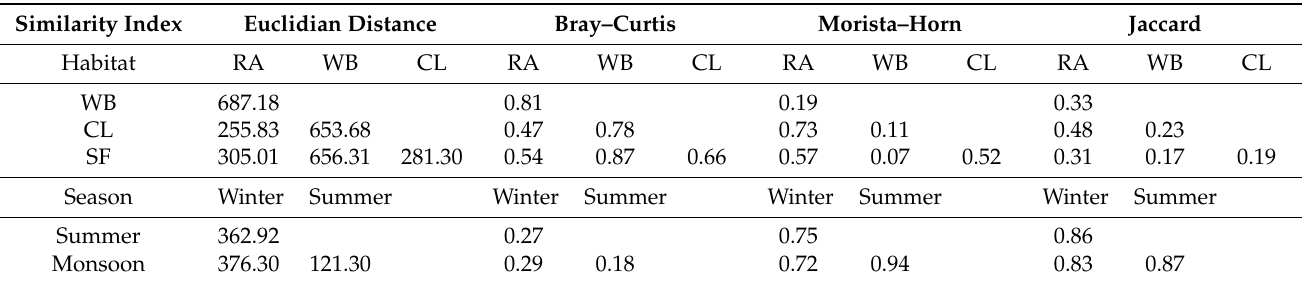
Figure 8. The pie chart represents the occurrence of birds feeding guild richness (%) in the study area; C = Carnivore, F = Frugivore, G = Granivore, I = Insectvore, N = Nectarivore, and O = Omnivore.